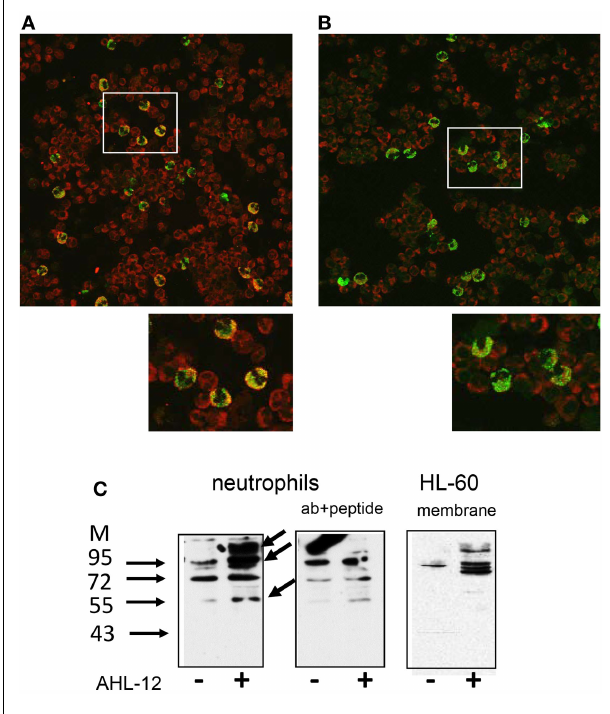
FIGURE 6 | Co-localization of AHL-12 and T2R38: neutrophils were incubated with AHL-12-FITC, placed on slides, fixed, and incubated with either (A) anti-T2R38 or (B) isotypic antibody . Laser scan microscopy shows co-expression of T2R38 and AHL-12-FITC as “yellow cells.” The isotypic antibody shows some background staining, but the majority of cells remained “green.” Selected areas (white rectangles) were zoomed to show details. (C) A pull-down assays showed binding of AHL-12 to T2R38: AHL-12-biotin was incubated with neutrophils; then lysates were prepared, and incubated with streptavidin beads, and the eluates were subjected to SDS-PAGE and Western blotting using anti-T2R38 sc-34294 (lanes marked with + ). In comparison to neutrophils having not been exposed to AHL-12-biotin (lanes marked with (cid:0) ), major bands were seen, at 100–130kDa, and 55kDa, the intensity of which could be reduced with the specific antigen peptide. Experiments with HL-60 showed essentially similar results. Here, membrane preparations are